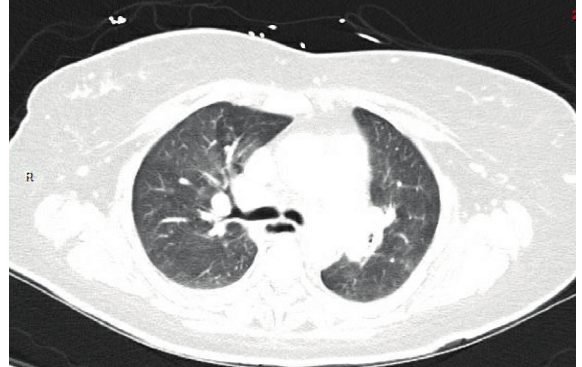
Figure 3: Computed tomography of the abdomen revealing multiple nodules of the liver and